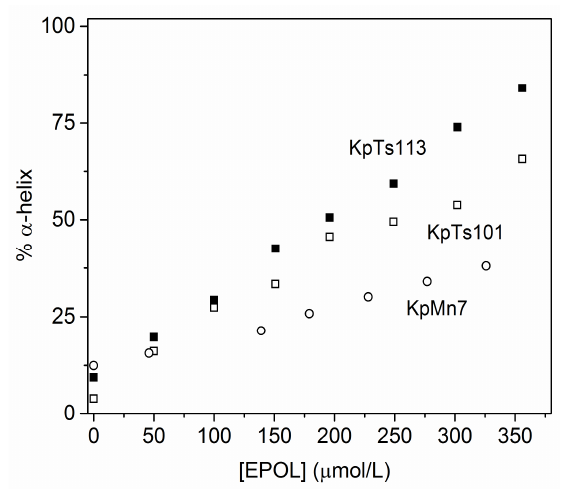
Figure 2. Percentage of α-helix of BMAP-27 induced by the EPOLs purified from KpTs101, KpTs113, and KpMn7 biofilms. [BMAP-27] = 20 μM, T = 25 °C, phosphate buffer.